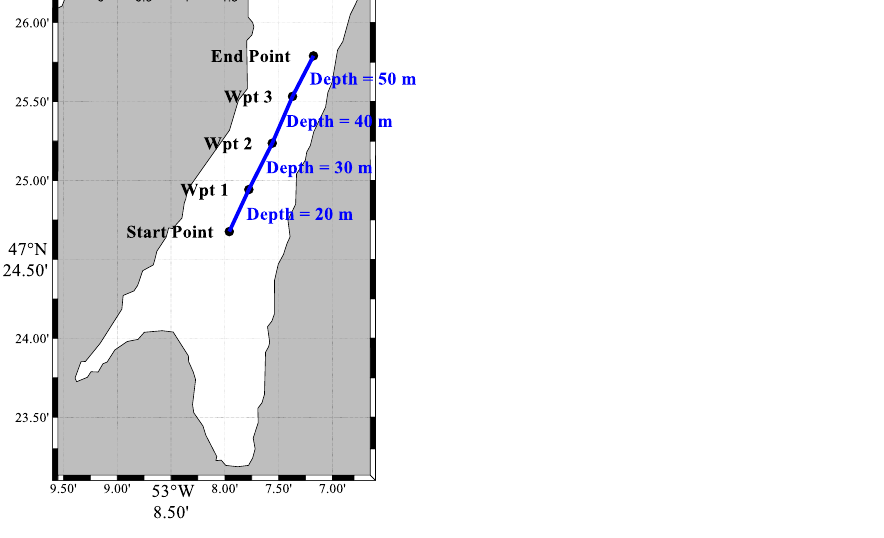
Figure 6. Trajectory of the Slocum glider in the mission of changing the maximum diving depth when a waypoint was reached. Table 2. Waypoint list for a mission of the Slocum glider with corresponding maximum diving depth after a waypoint was reached.